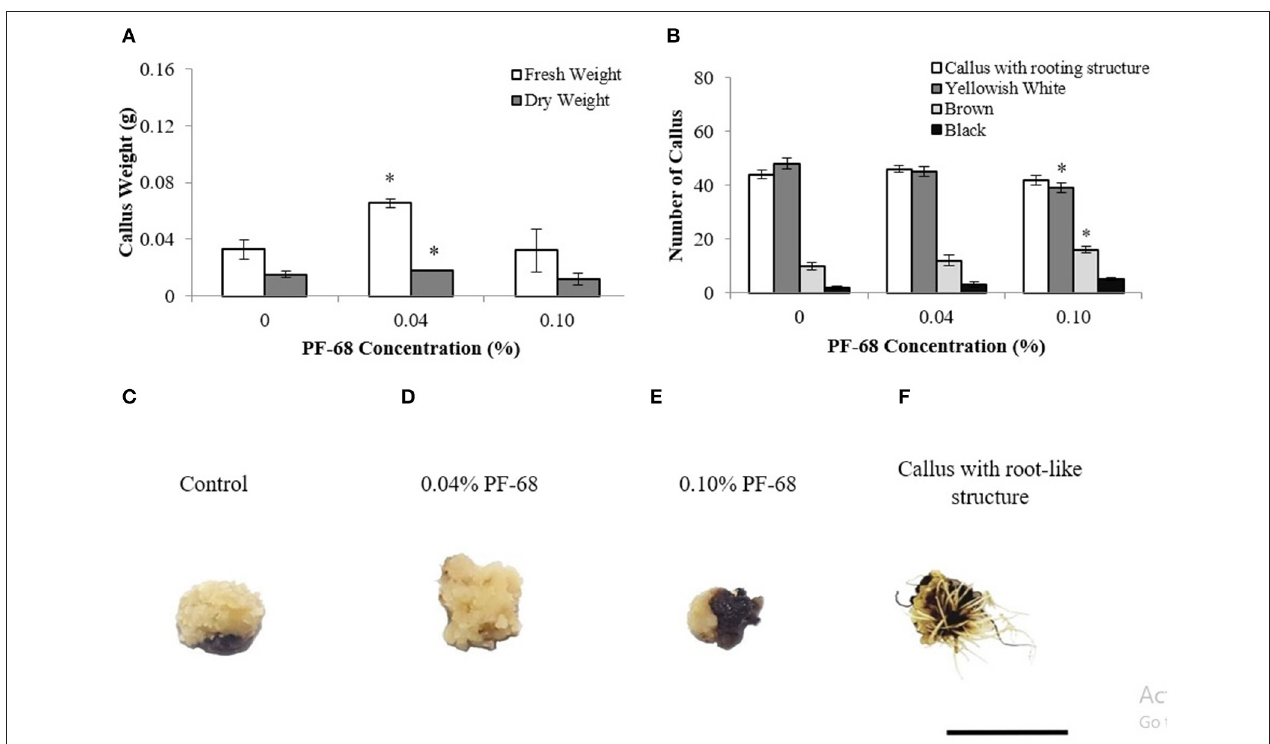
FIGURE 1 | Data obtained from calli proliferated on Murashige and Skoog (MS) medium supplemented with different PF-68 concentrations without plant hormones (MSO) for 3 weeks. (A) Mean fresh and dry weights recorded on 3 weeks old calli; (B) callus morphology on MSO (control), MSO + 0.04% and MSO + 0.10% PF-68; (C) control callus at week 3; (D) callus on MSO + 0.04% PF-68 at week 3; (E) callus on MSO + 0.10% PF-68 at week 3; (F) callus with root-like structure at week 3. Data shows the mean of three biological replicates. Asterisks (*) indicate statistical significant difference at p < 0.05 in Dunnet’s test. Scale bars represent 0.5cm. Error bars represent standard error